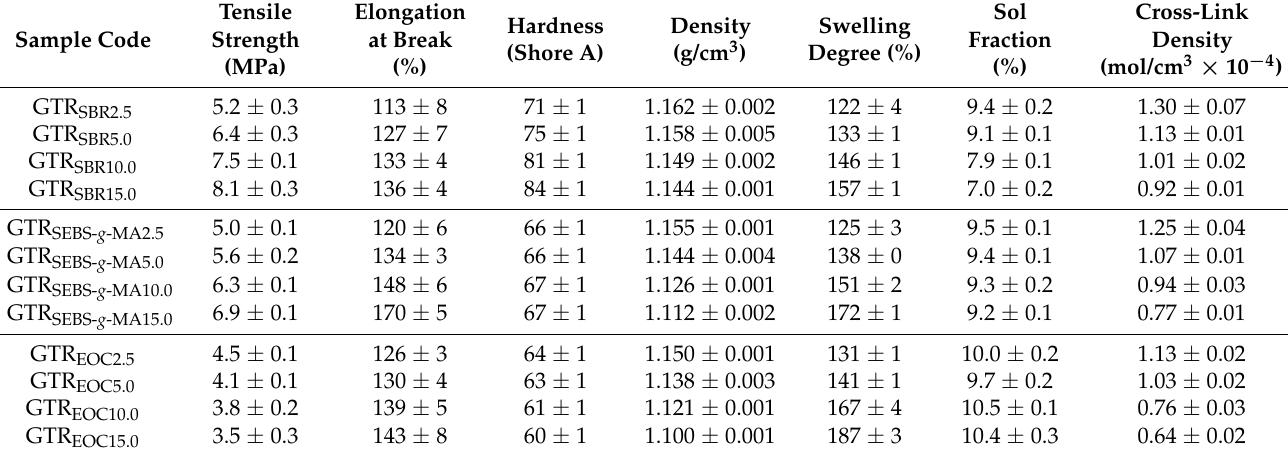
Table 4. Physico-mechanical properties of modified